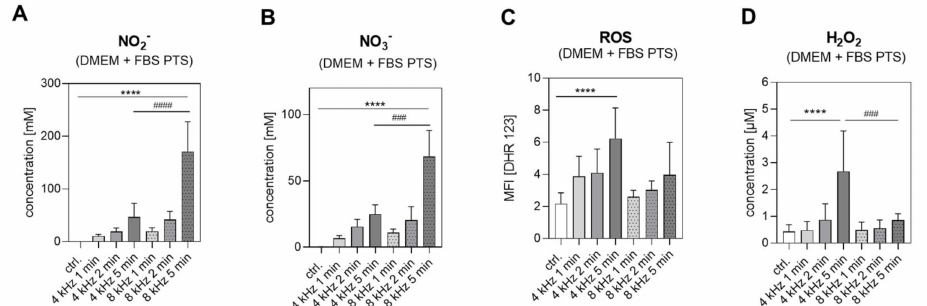
Figure 1. NO 2 − , NO 3 − , ROS and H 2 O 2 in DMEM + FBS PTS. In total, 2.5 mL of DMEM + FBS was CAP-treated with 4 kHz for 1, 2 and 5 min and with 8 kHz for 1, 2 and 5 min or remained untreated (control); (n = 3 in duplicated form). The ( A ) NO 2 − and ( B ) NO 3 − concentration [mM] in PTS was quantified using a colorimetric Nitrite/Nitrate Assay Kit. ( C ) The median fluorescence intensity (MFI) of DHR 123 was used as an indicator for CAP-induced ROS in PTS. ( D ) Using an H 2 O 2 standard series, the Fluorometric Hydrogen Peroxide Assay Kit was used to determine the H 2 O 2 concentration [ µ M] in PTS. Statistical analysis: Bonferroni’s multiple comparisons test. **** p < 0.0001 (4 kHz, 8 kHz versus control), ### p < 0.001, #### p < 0.0001 (4 kHz versus 8